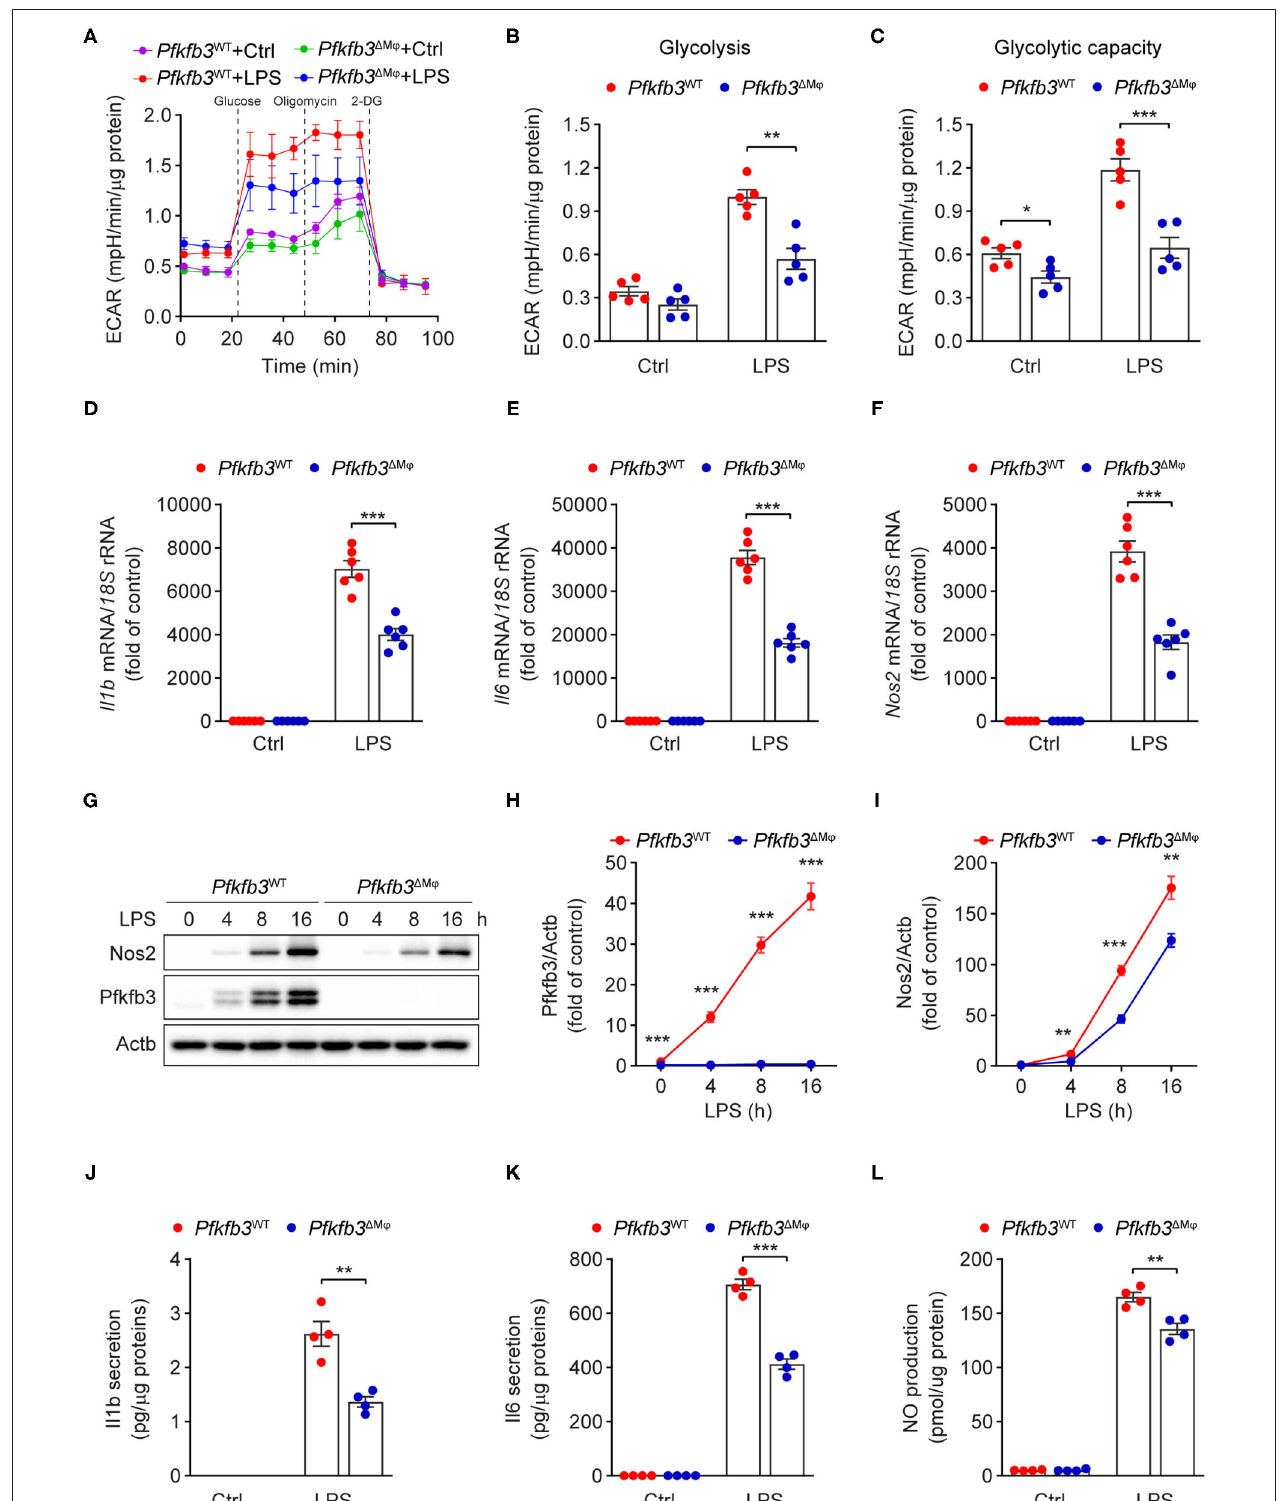
FIGURE 6 | Enhance glycolysis in macrophages supports their proinflammatory activity upon LPS stimulation. (A) ECAR profile shows glycolytic function in Pfkfb3 WT and Pfkfb3 1 M φ BMDMs treated with LPS (100ng/mL) for 6h ( n = 5). (B,C) Quantification of glycolysis [ (B) , ECAR after glucose addition and subtracted by the average of basal values] and glycolytic capacity [ (C) , ECAR after oligomycin addition and subtracted by the average of basal values] from (A) ( n = 5). (D–F) qPCR